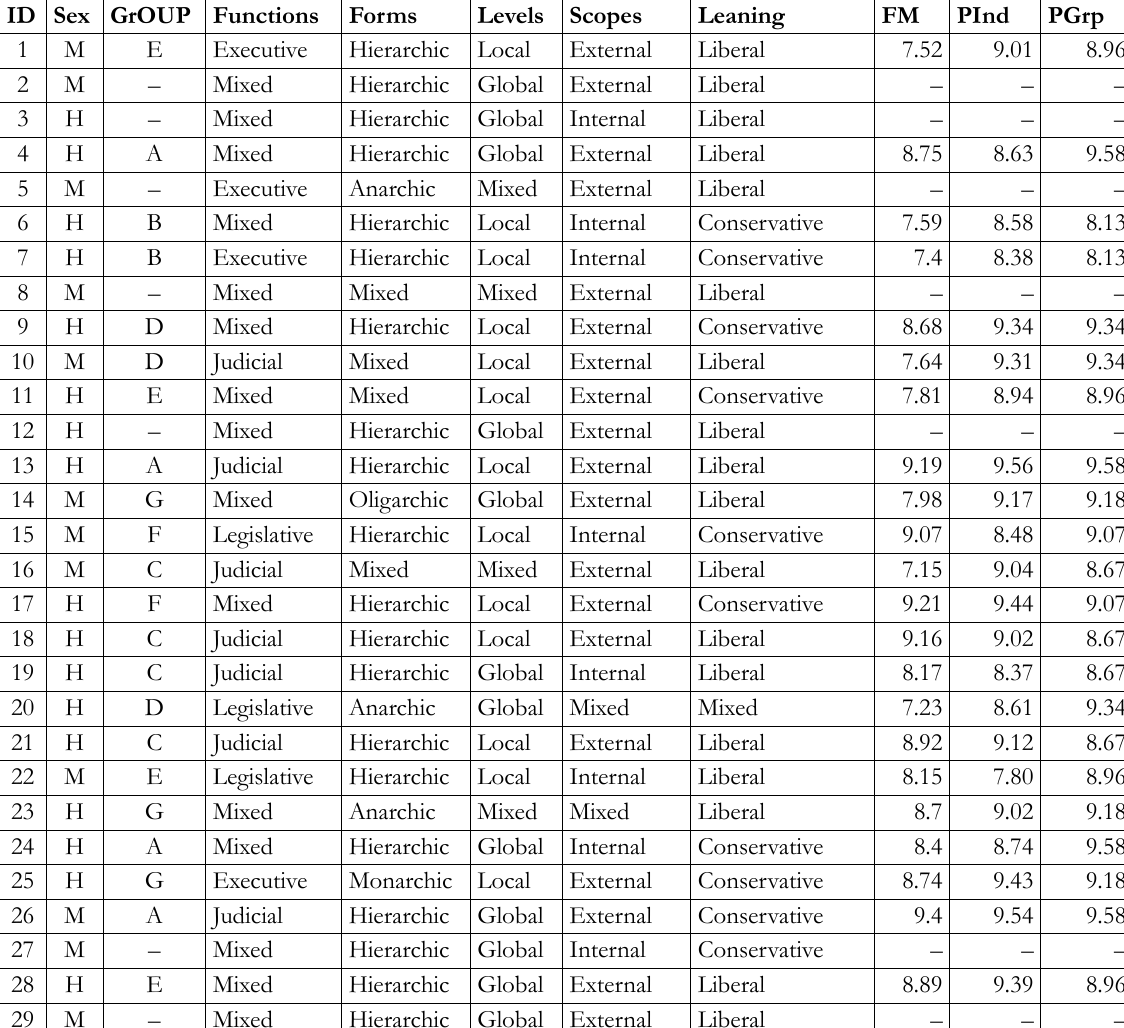
Table 2. Individual thinking styles. Paired with sex, picked group and marks